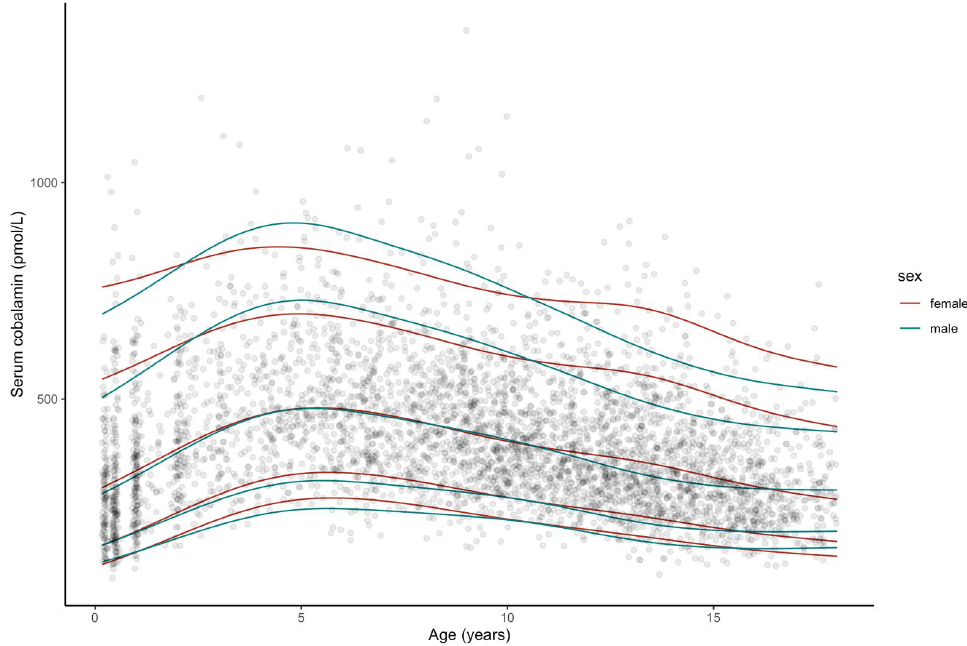
Figure 2. Smoothed percentile curves for serum cobalamin concentrations according to age based on a sample of generally healthy participants from the LIFE Child study population. In total, there are 4229 observations from participants aged 2 months–18 years, single data points depicted. From bottom: 2.5th (P2.5), 10th (P10), 50th (P50, median), 90th (P90), 97,5th (P97.5) percentiles are marked. Smoothed percentiles produced with Cole’s LMS-type method. Figure 1 illustrates the age-specific patterns in folate concentration levels. There is a clear continuous downward trend with increasing age in both sexes. The slope is steepest during the first four years of life. Thereafter, a gentler decline is observed. At age 13, the median percentiles of folate concentration in males and females intersect, indicating a slightly steeper fall in concentrations in teenage boys. The range between the 2.5th and the 97.5th percentiles is largest during infancy and decreases thereafter. Both intra- and inter-age group comparisons found large variances in measurements. Figure 2 reveals a sharp increase in cobalamin concentrations during the first five years of age, with the 97.5th percentile peaking at 906.54 pmol/l. Thereafter, cobalamin levels decline rapidly. While girls tend to present higher cobalamin levels following birth and during the first year of life, in the upper percentiles, concentrations subsequently rise more rapidly in boys. Passing the 15-year age mark, the slope of decline flattens mark- edly. Similar to folate, measurements vary widely between ages and within age-groups. 3.3. Sex, BMI-SDS and SES as Potential Determinants of Serum Folate and Cobalamin Status Tables 2 and 3 detail the results of the intercorrelation analysis. An inverse correla- tion was identified between BMI-SDS and folate ( p < 0.001) and cobalamin (Figure S2). The association between cobalamin (but not folate) and BMI-SDS grew stronger with in- creasing age ( p < 0.001) (Figure 3). Higher SES was significantly associated with higher folate levels (Figure S3). The effect of SES on folate increased with age ( p < 0.001) (Figure 4). No significant relationship between SES and cobalamin was detected ( p = 0.308).